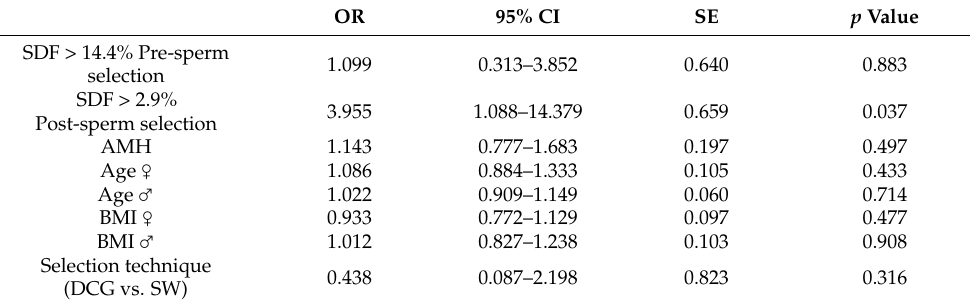
Table 7. Odds Ratio (OR), confidence interval (95% CI) and standard error (SE) from logistic regression models. (dependent variable: non-viable embryos).